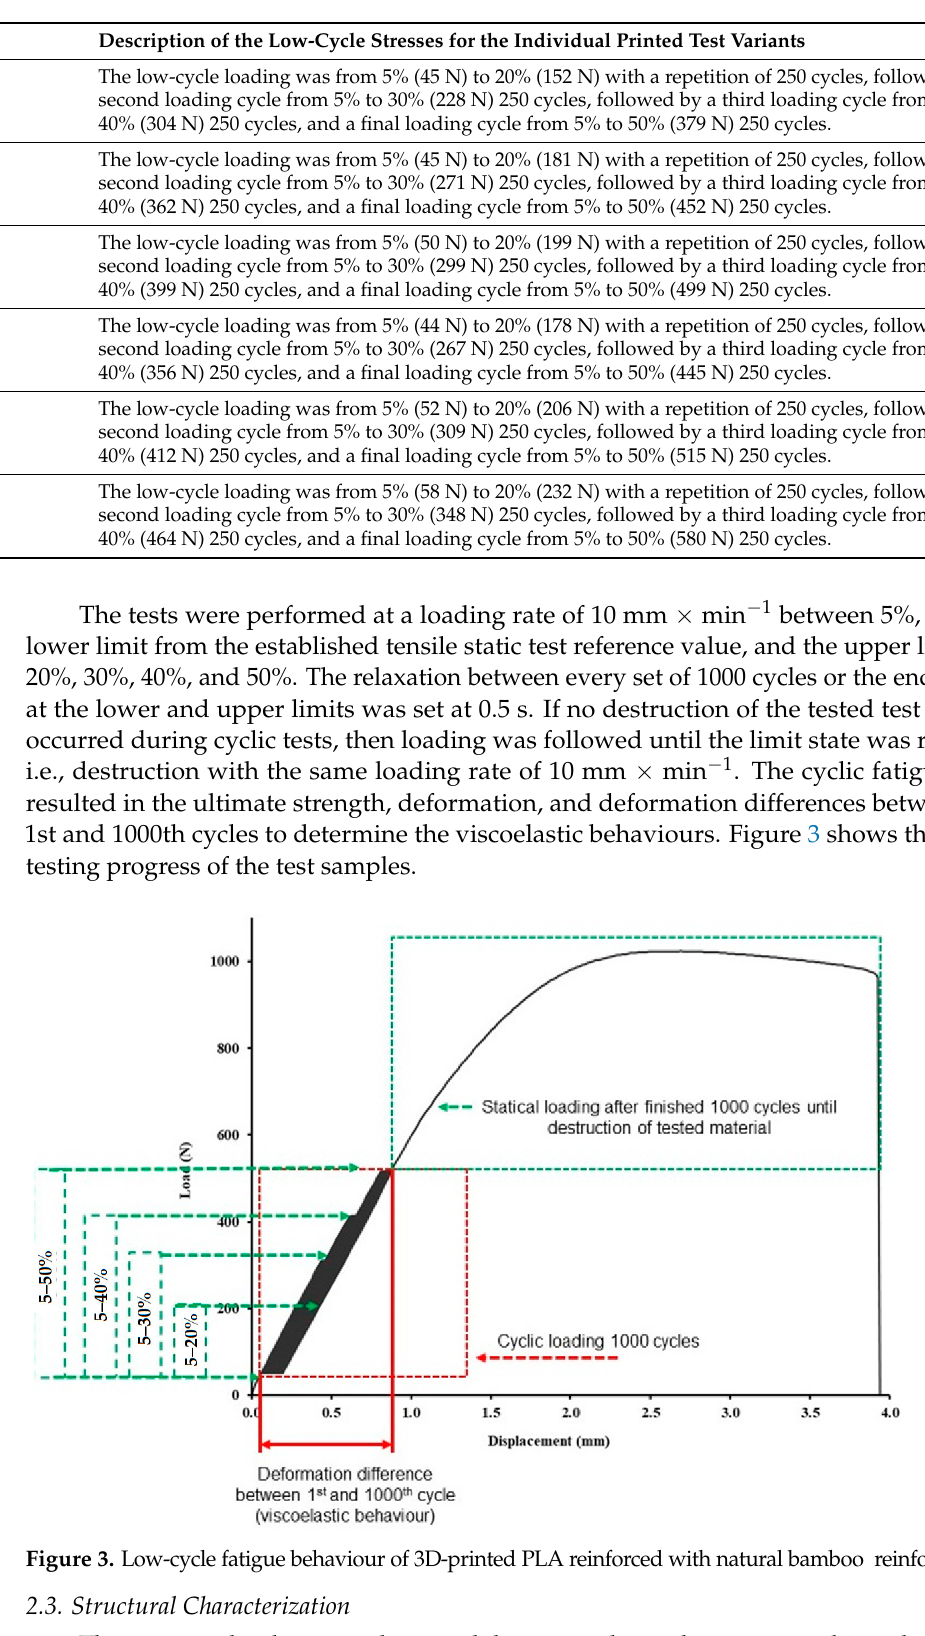
Table 2. Low-cycle test setup parameters for each experiment variant tested.